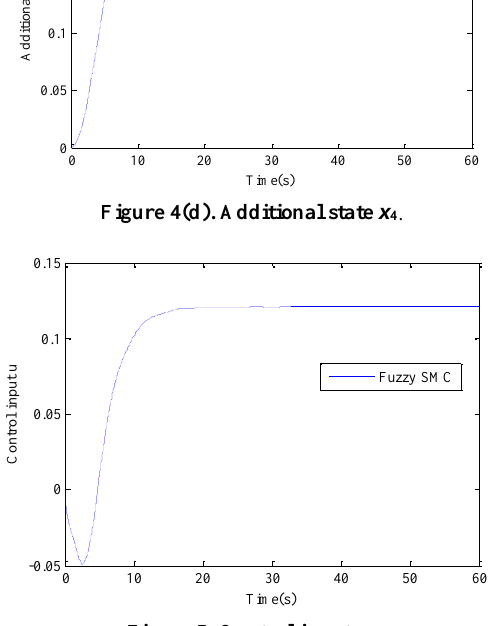
Figure 4(a). Speed deviation x 1.